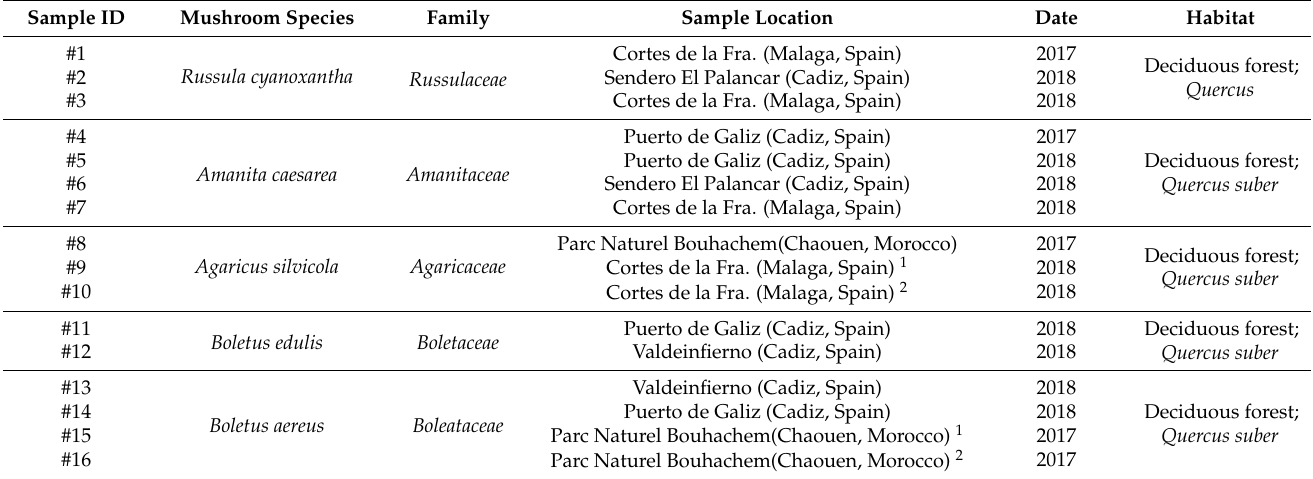
Table 1. Sample ID, mushroom species, family, sample location, collection date, and habitat descrip- tion of wild edible mushroom species